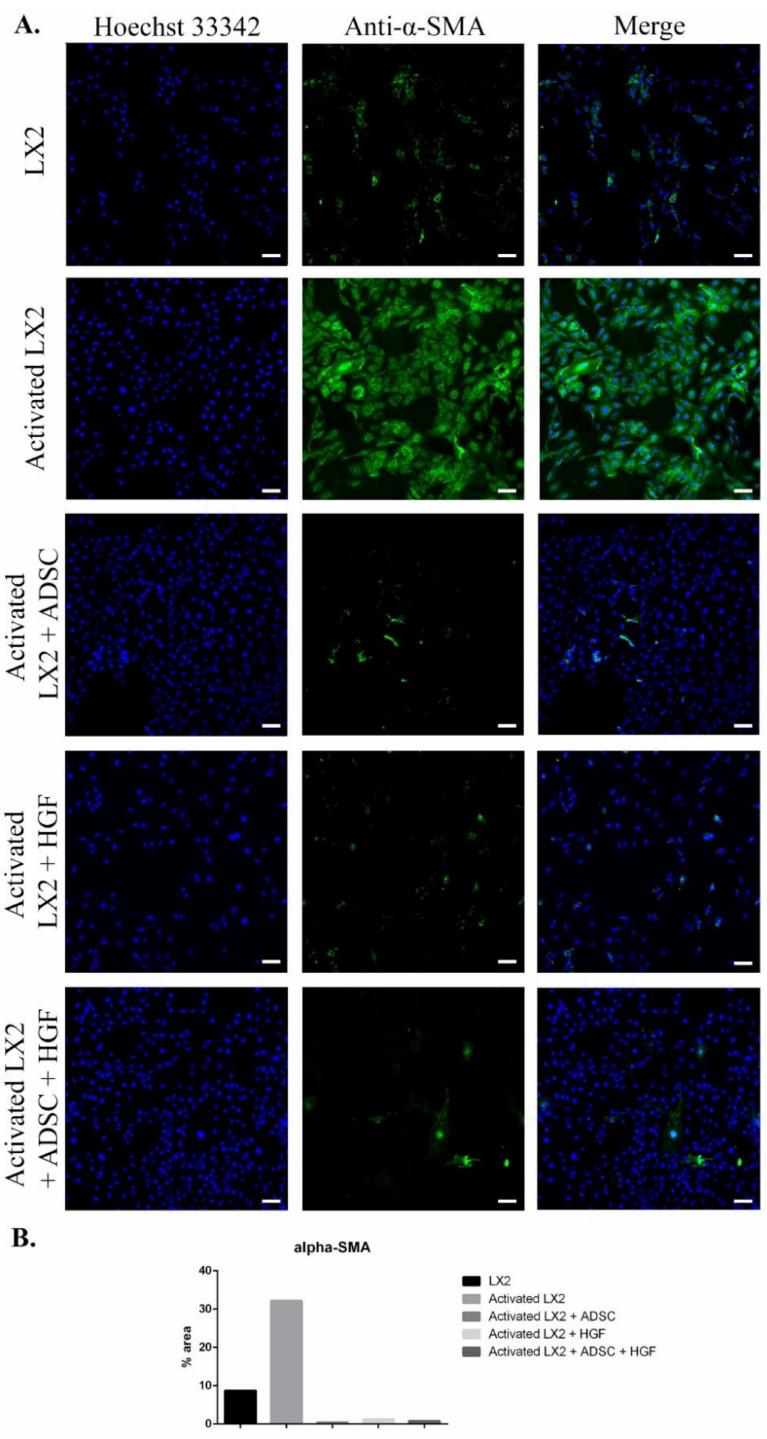
Figure 2. Evaluation of α -SMA expression in the following conditions: LX2, activated LX2 (induced with TGF- β 1), activated LX2 + ADSC (activated LX2 cocultured with ADSCs), activated LX2 + HGF (activated LX2 treated with HGF), activated LX2 + ADSC + HGF (activated LX2 co-cultured with ADSC, treated with HGF). ( A ) Immunofluorescence staining of α -SMA (antibody conjugated with AF-488, green), nuclei of the cells stained with Hoechst 33342 (blue); ( B ) quantification of the im- munofluorescence staining of α -SMA; scale bar: 100 µ